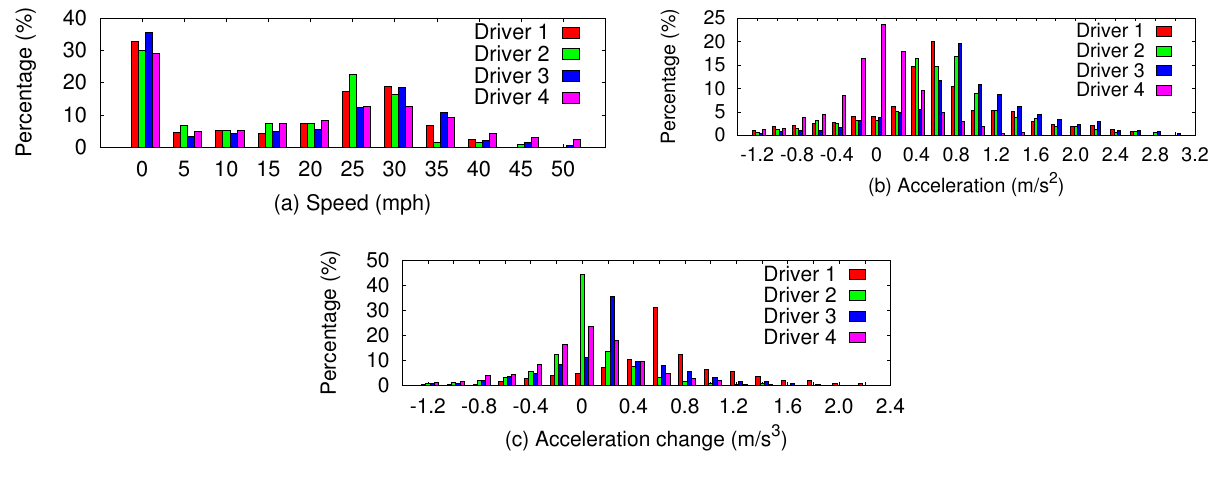
Figure 8. Speed and acceleration comparison of four different drivers on the same